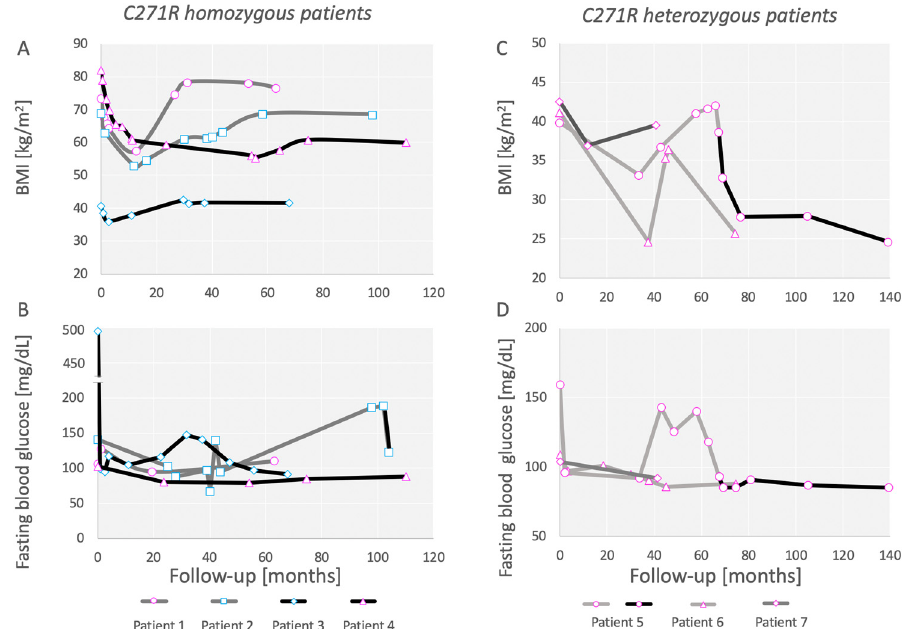
Figure 2. BMI and fasting blood glucose levels of patients presented in this study. ( A , B ) Patients carrying homozygous C271R mutation. BMI ( A ) and fasting blood glucose ( B ) as a function of time after surgery in months. Note, in ( B ), that the axis is broken over 250 mg/dL. ( C , D ) Patients carrying a single allele of the C271R mutation. BMI ( C ) and glucose ( D ) as a function of time after surgery in months. Color code: LAGB, light gray; LSG, dark gray; LRYGB, black. Patient 3 had a revision into LOAGB and patient 5 had a revision into LRYGB. Female patients are denoted in pink markers, while male patients are denoted in light blue.